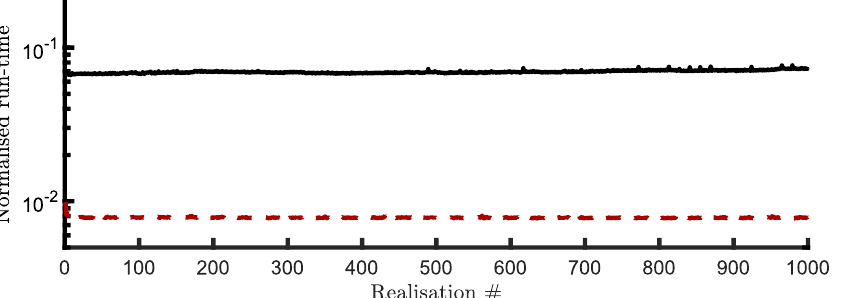
Figure 11. Normalised run-time required to solve the target nonlinear WEC model (solid black), and the reduced model by moment-matching (dashed